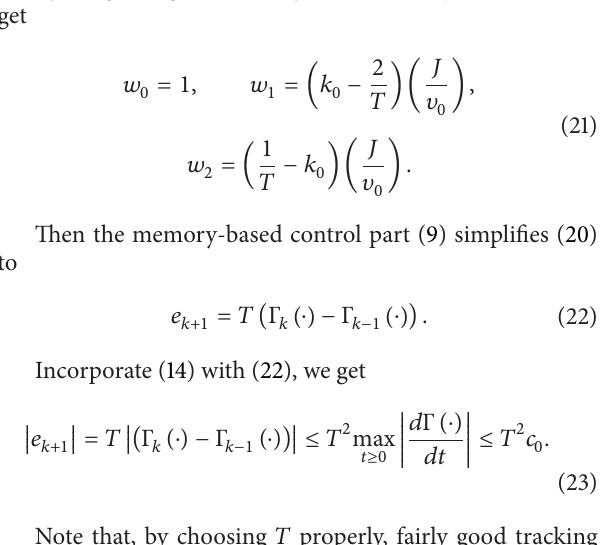
Figure 6: Wind and wave